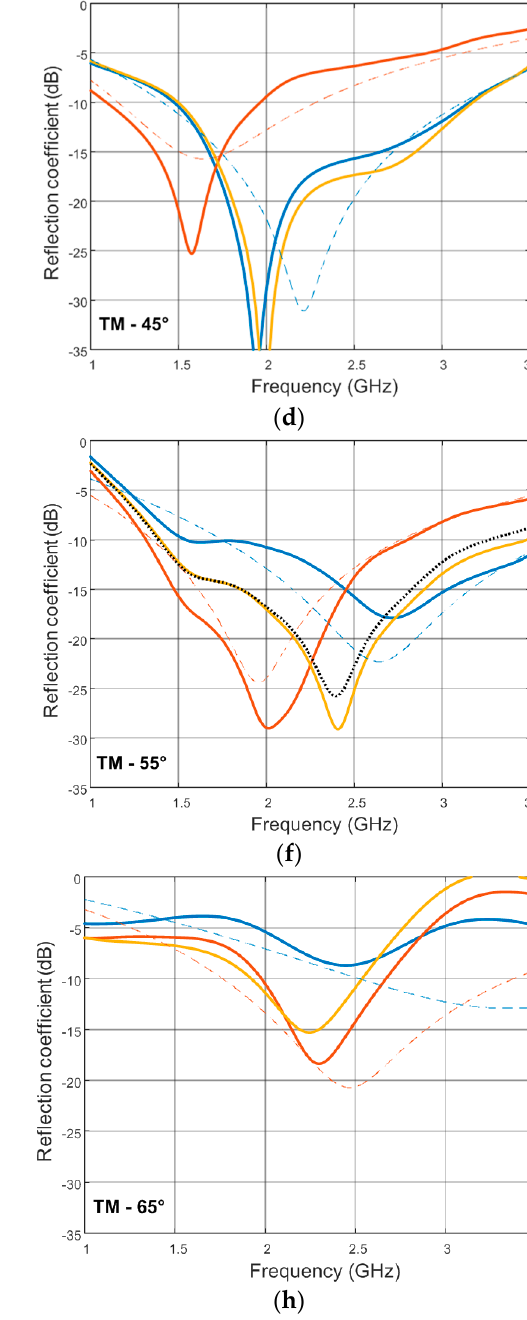
Figure 10. Bistatic measurement of the sectorial absorber for TE polarization at 35 ◦ ( a ), 45 ◦ ( c ), 55 ◦ ( e ) and 65 ◦ ( g ) and TM polarization at 35 ◦ ( b ), 45 ◦ ( d ), 55 ◦ ( f ) and 65 ◦ ( h ). The measurements of sectorial absorber A + B is compared against uniform absorbers A + A and B + B and also with the simulation of uniform infinite absorbers A and B.